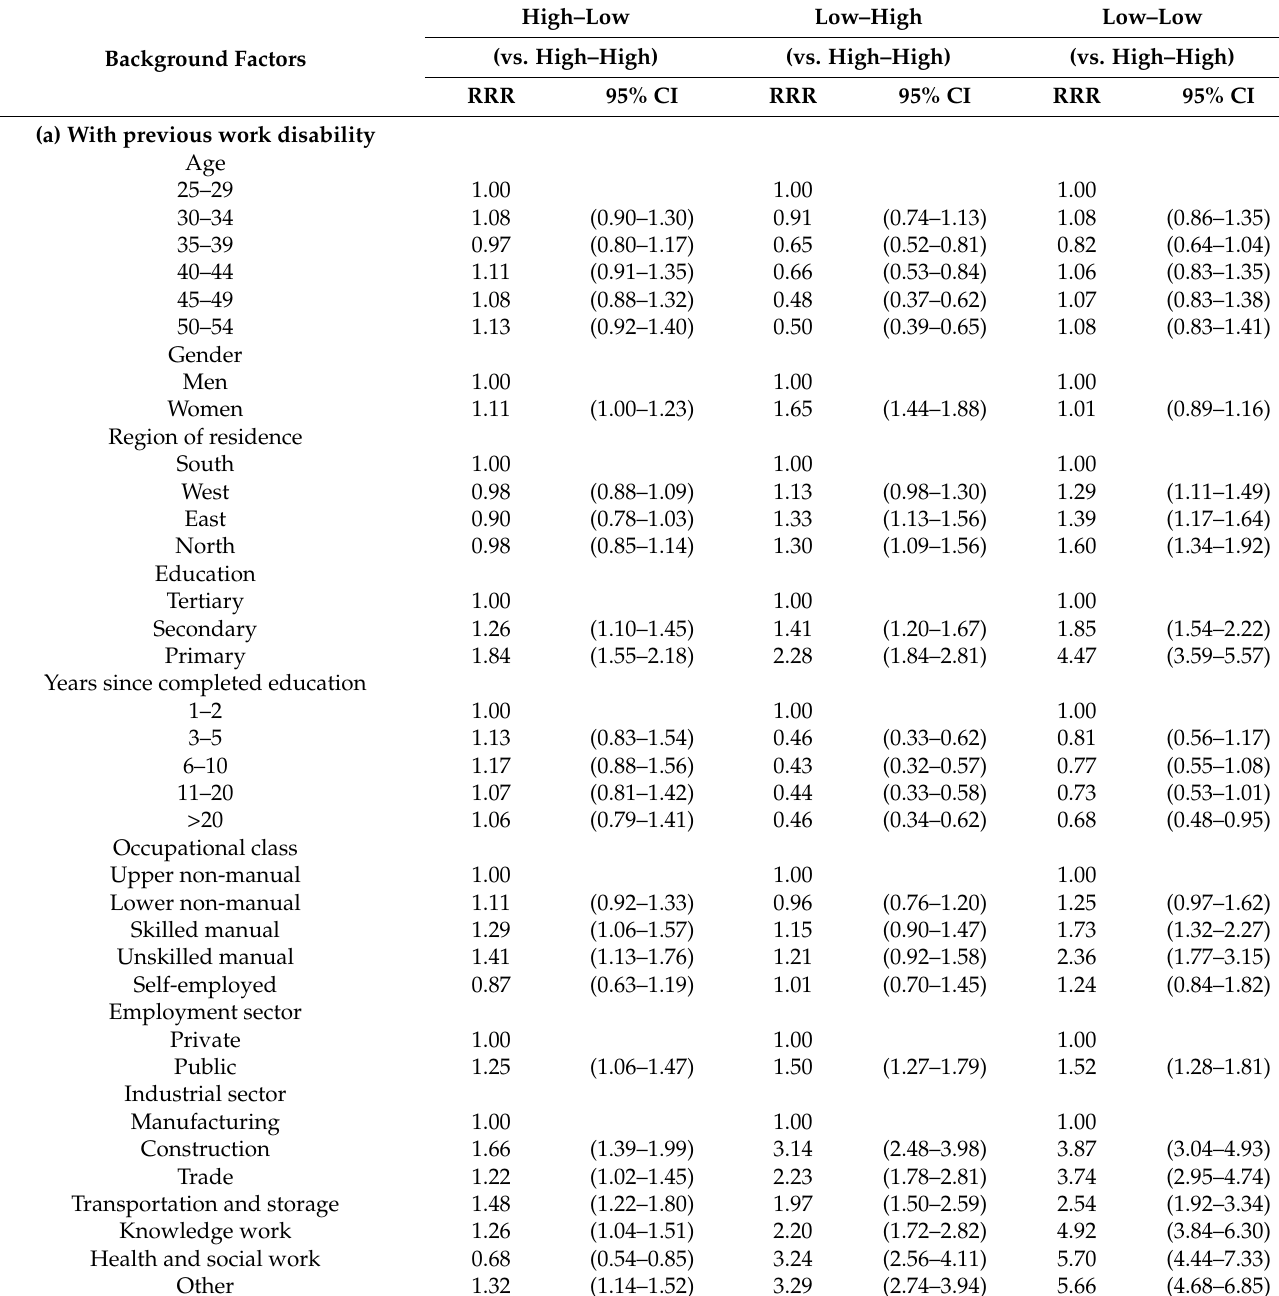
Table 3. Relative risk ratios (RRR) and 95% confidence intervals (CI) for being assigned to the trajectory groups of work participation in the open labour market before and after vocational labour market training by mutually adjusted background factors amongst those ( a ) with ( n = 11,669) and ( b ) without ( n = 25,969) previous work disability in the subpopulation with occupational